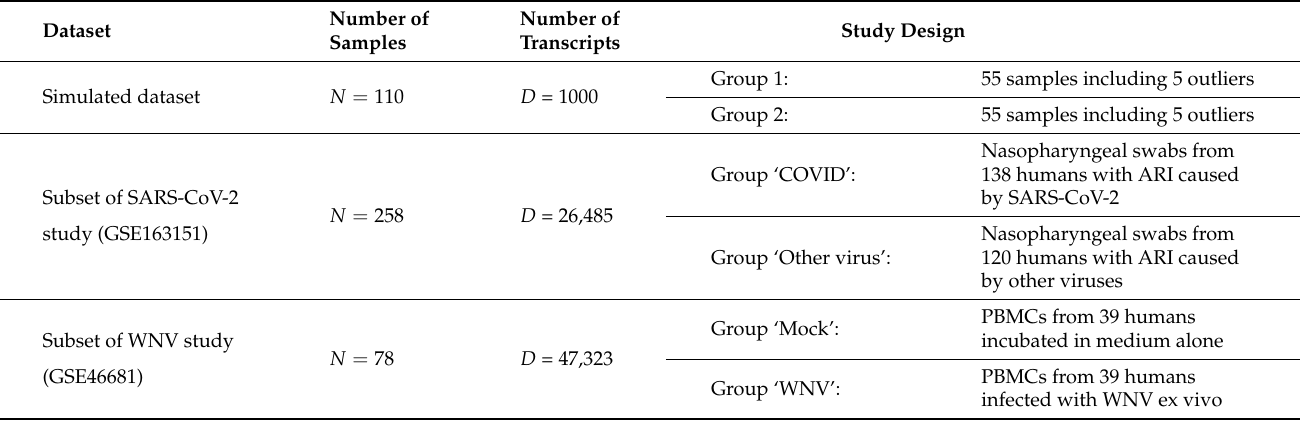
Table 1. Structure of the three different datasets that were used for assessment of outlier probabilities and classifier models. The SARS-CoV-2 dataset was generated by RNA-Seq, and the WNV